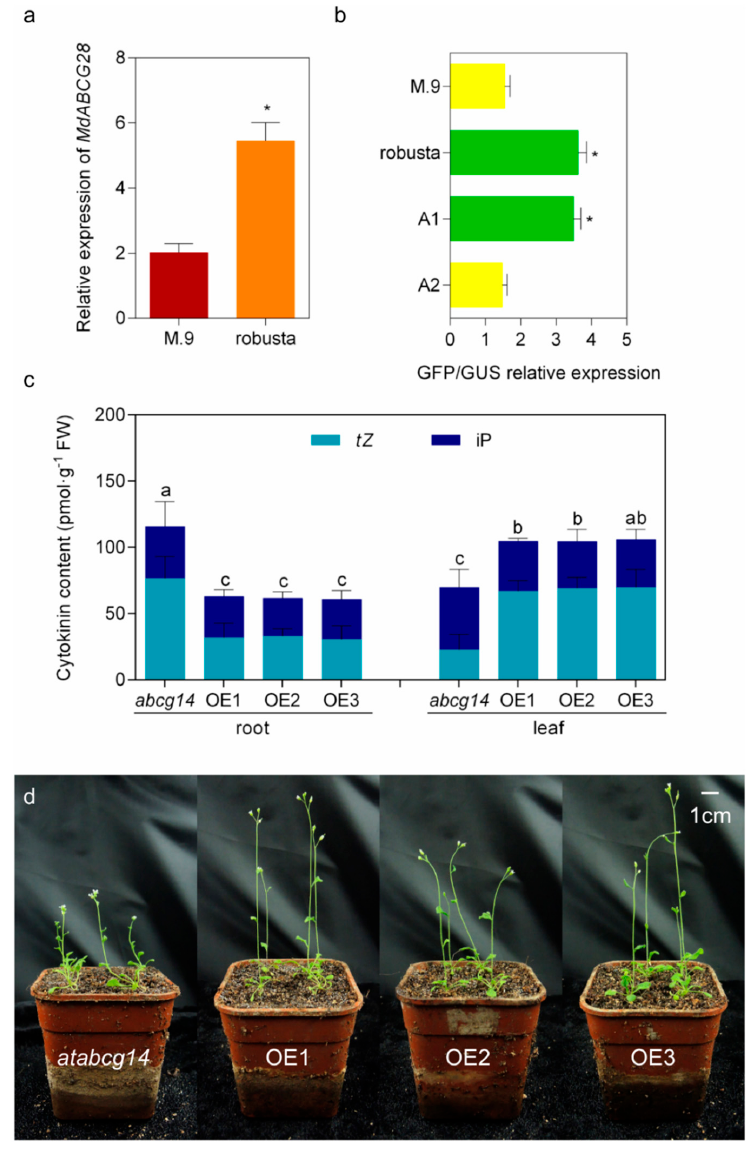
Figure 4. Functional analysis of MdABCG28 and its variant promoter. ( a ) Relative expression of MdABCG28 in roots of apple rootstocks. ( b ) Transient GFP expression assay in Arabidopsis protoplasts testing the e ff ects of the 17 bp deletion variant in the MdABCG28 promoter. The 2 kb promoter region of MdABCG28 was amplified and cloned into the pCambia1302 vector (GFP tag) by inserting it into the EcoRI / KpnI site. The M.9 construct contained a 17 bp deletion sequence (-GAACCGTC TTGAC ATGT-) in the region from 1186 to 1202 bp with a W-box (-TTGAC-) compared with the robusta construct. The A1 construct was generated on the basis of the M.9 construct with a 17 bp deletion sequence inserted back. The A2 construct was generated on the basis of robusta construct with W-box mutated (-GAACCGTC TTCAC ATGT-). The pCAMBIA1301 vector (GUS tag) was used as internal control. The panel shows the GFP expression levels relative to GUS ( n = 10). ( c ) Cytokinin contents and ( d ) phenotypes of the atabcg14 mutant and its overexpressed lines of MdABCG28 . The full-length cDNA of MdABCG28 was amplified and cloned into the pCambia1300 vector by inserting it into the EcoRI / KpnI site. The resulting recombinant vector was inserted into Agrobacterium tumefaciens LBA4404 cells to transform atabcg14 mutant plants. Homozygous T3 transgenic lines were used. Biological replicates were performed in triplicate. Error bars represent the standard error. Asterisks indicate p -values below 0.05, obtained using a two-tailed Student’s t -test. Di ff erent letters indicate p -values below 0.05, obtained using Duncan’s